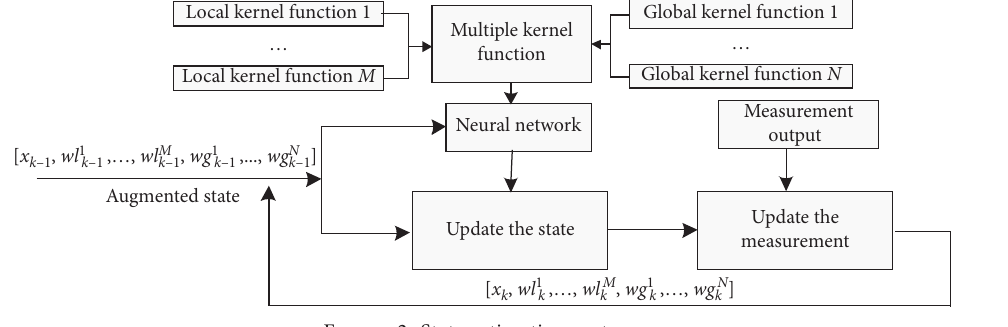
Figure 2: State estimation